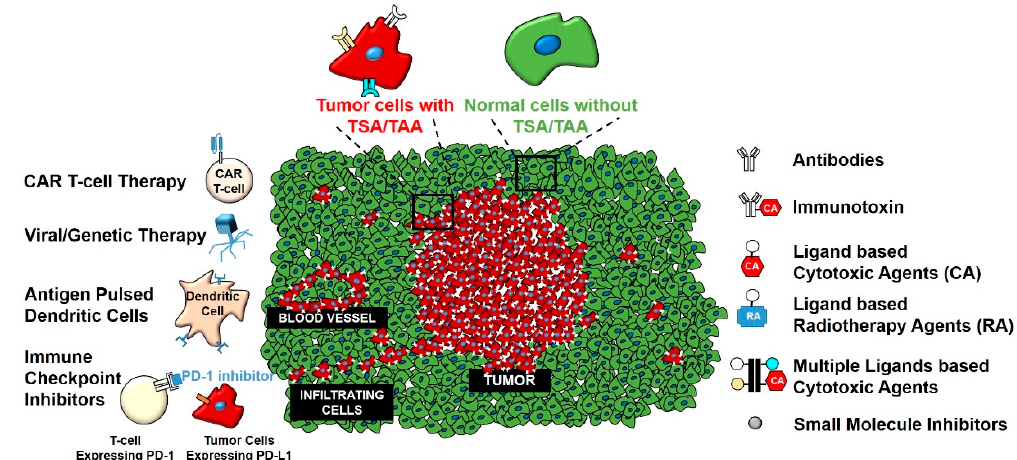
Figure 1. A schematic of various targeted therapies used to treat glioblastoma. Tumor cells express Tumor Specific Antigen/ Tumor Associated Antigen (TSA/TAA) that are lacking in healthy neighboring normal cells. These therapies specifically target the TSA/TAA to limit the cytotoxic/radio therapeutic effects to tumor cells and spare their normal counterparts.